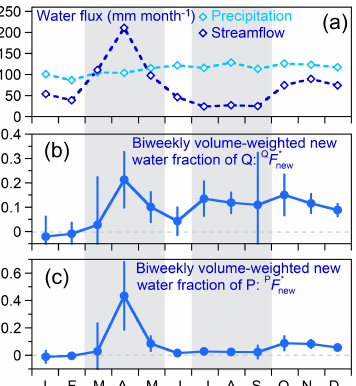
Figure 11. Seasonal patterns in (a) average precipitation and streamflow fluxes, (b) biweekly volume-weighted new water frac- tions of streamflow Q F ∗ new (fraction of streamflow derived from precipitation that fell in the previous 2 weeks), and (c) biweekly volume-weighted new water fractions of precipitation P F ∗ new (frac- tion of precipitation that becomes streamflow within the follow- ing 2 weeks), as determined from ensemble hydrograph separation (Eqs. 32 and 33; Fig. 10). Dashed lines in (b) and (c) indicate new water fractions of zero. Average precipitation fluxes (a) vary lit- tle from month to month, whereas average streamflow fluxes show clear high flows resulting from snowmelt from March through May and clear low flows attributable to evapotranspiration losses from July through September. Both intervals are marked by gray shad- ing. Ensemble hydrograph separations imply that recent (previous 2 weeks) precipitation comprises about 20% of streamflow during the snowmelt peak in April, roughly 0% (within error) during the cold winter months of January, February, and March, and roughly 10% (within error) during the rest of the year. These streamflow fractions can be re-expressed as fractions of precipitation by multiplying by monthly streamflow and dividing by monthly precipitation. The re- sulting biweekly new water fractions of precipitation quantify the fractions of precipitation that leave the catchment as streamflow within the following 2 weeks (c) . These are zero within error in January, February, and March, rise to 43% during April snowmelt, decline to 2% or less throughout the growing season (June through September), and then rise to 5%–9% during October, November, and